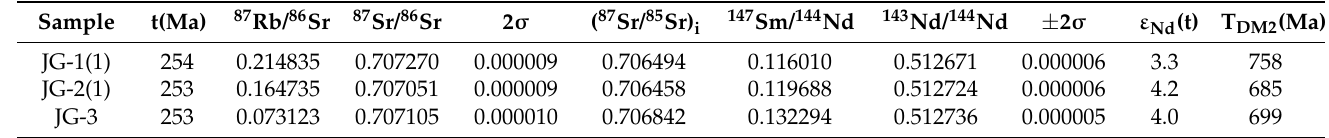
Table 2. Sr–Nd isotopic data for the Late Permian granitic pebble samples from the Jin (cid:48) gui